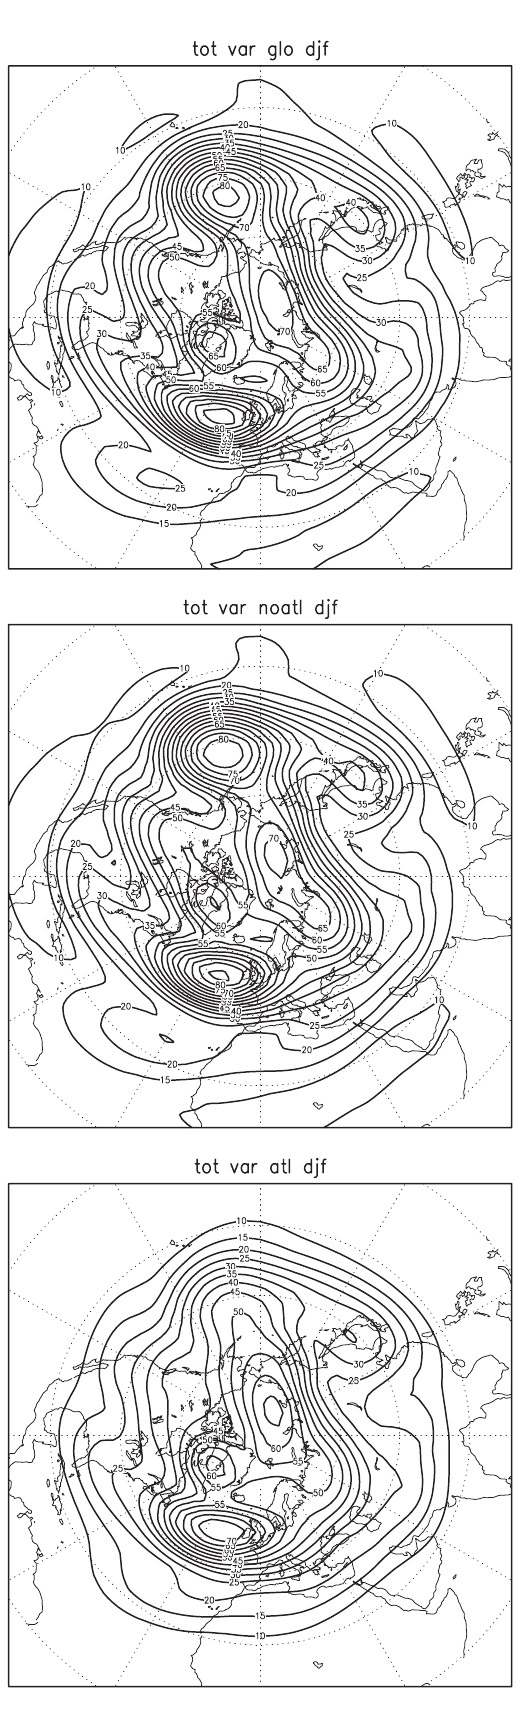
Fig. 1. Total variability (expressed as interannual standard deviation, in meters) for winter (December- January-February) 500-hPa geopotential height in respectively GLOBAL, NOATL and ATL